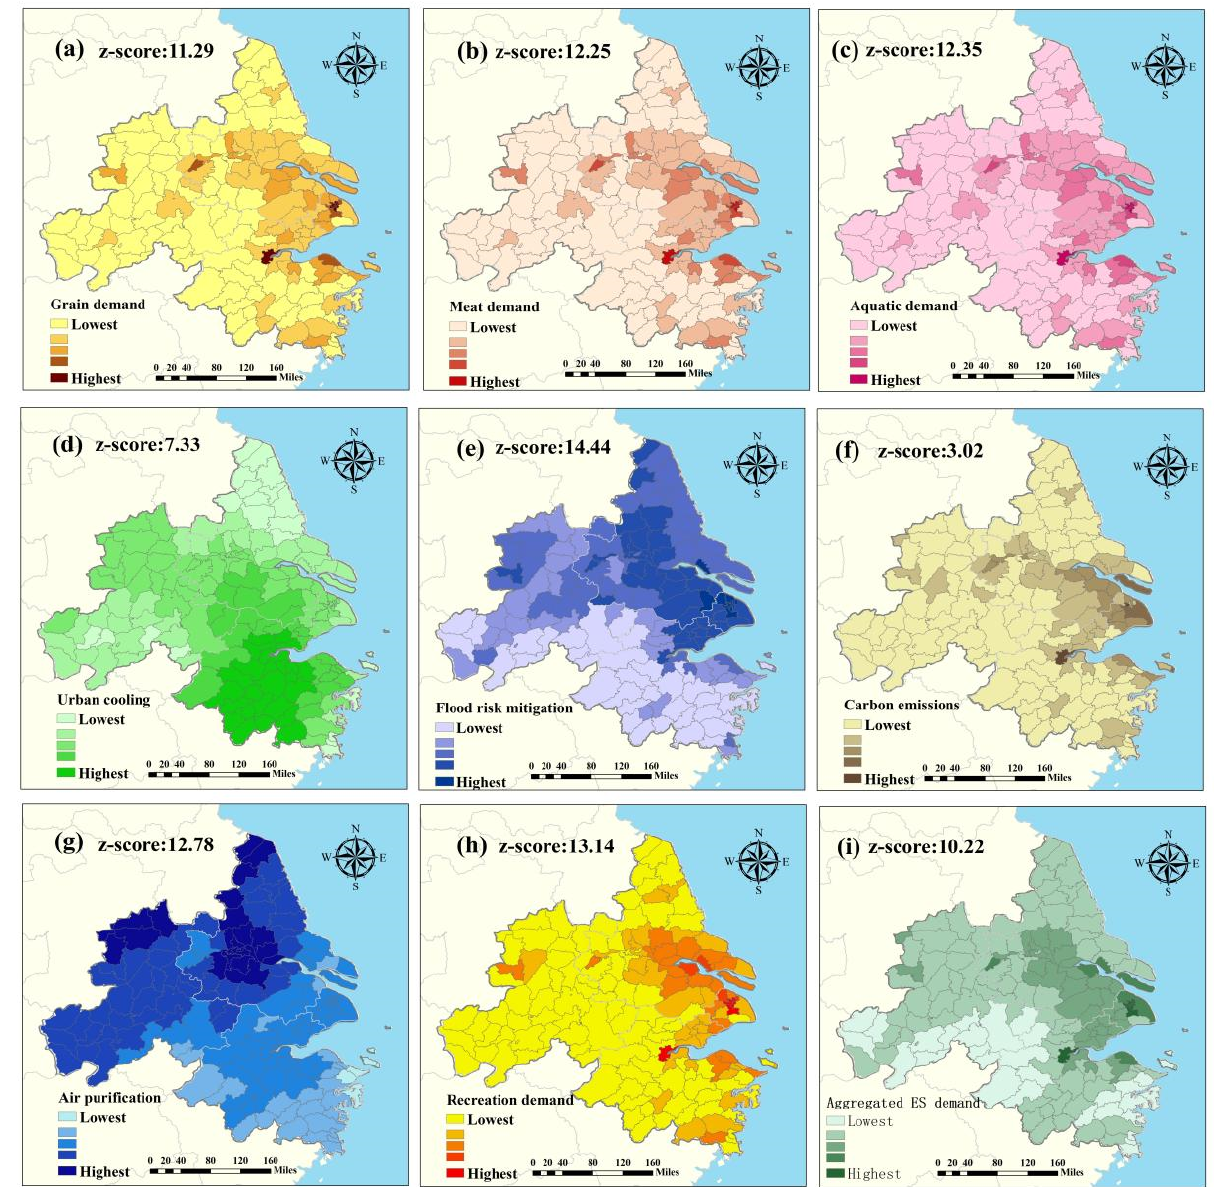
Figure 4. The spatial distributions of individual ES demand indicators ( a – h ) and aggregated ES de- mand capacity (i). The z-score values in each panel indicate the significance of spatial autocorrela- tion.